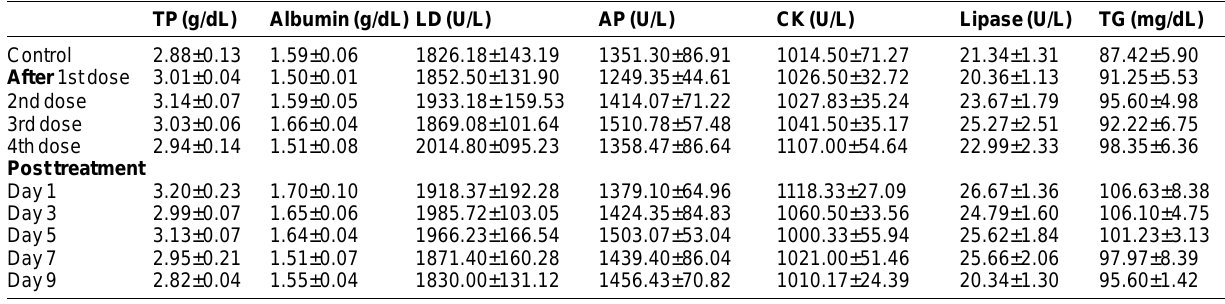
Table-1. Effect of enrofloxacin administration (10mg/kg body weight, in drinking water for 5 successive days) on total protein, albumin, lactate dehydrogenase, alkaline phosphatase, creatine kinase, lipase and triglyceride levels (data is shown as Mean±SE, n=6)